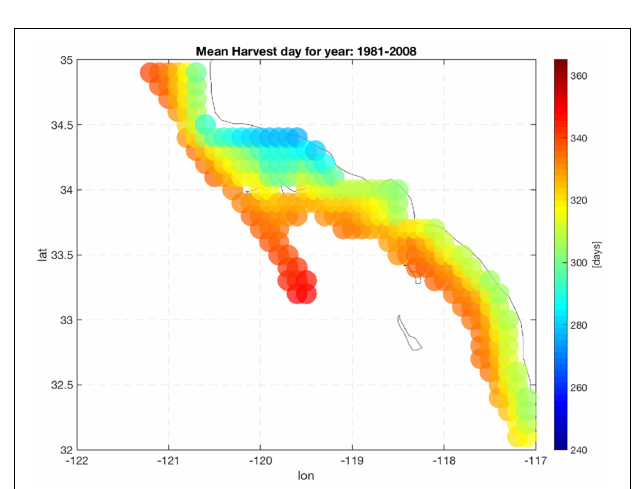
FIGURE 6 | Mean harvest time length. Color indicate the number of days required to grow mussels up to the commercial size (23